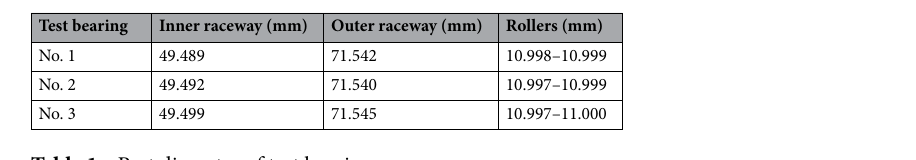
Table 1. Part diameter of test